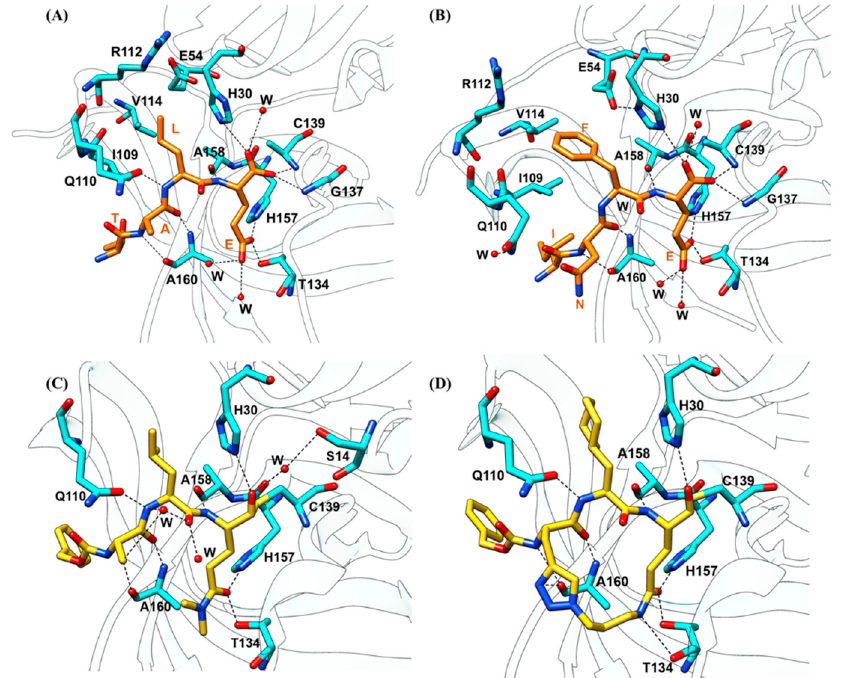
Figure 5. Binding and recognition of substrates and inhibitors to the HuNoV protease. ( A ) Binding of the TALE substrate (orange) to the Norwalk protease (cyan) (PDB ID: 4IN2). Water molecules are represented as red spheres. ( B ) Binding of the INFE substrate (orange) to the Norwalk protease (cyan) (PDB ID: 4IN1). ( C ) Binding of the Syc59 inhibitor (yellow) to the Norwalk protease (cyan) (PDB ID: 4INH). ( D ) Binding of the macrocyclic inhibitor 1 (yellow) to the Norwalk protease (cyan) (PDB ID: 6BIB). Oxygen and nitrogen atoms are labeled in red and blue, respectively.